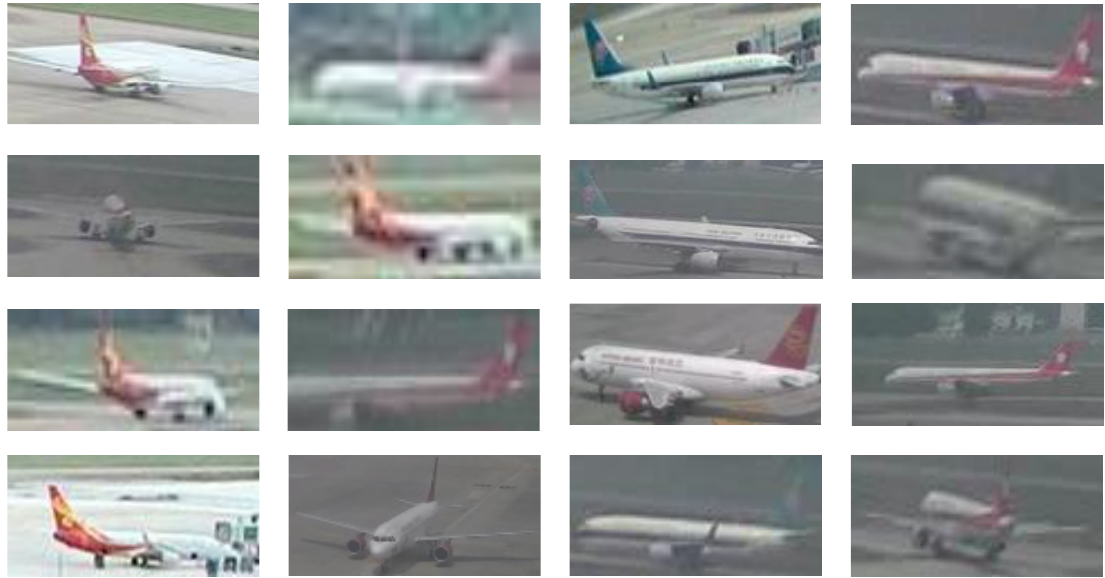
Figure 8. Airport surface surveillance